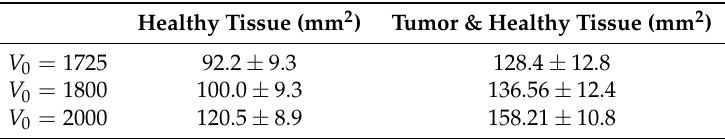
Table 7. Ablation sizes for IRE threshold at >700 V/cm.